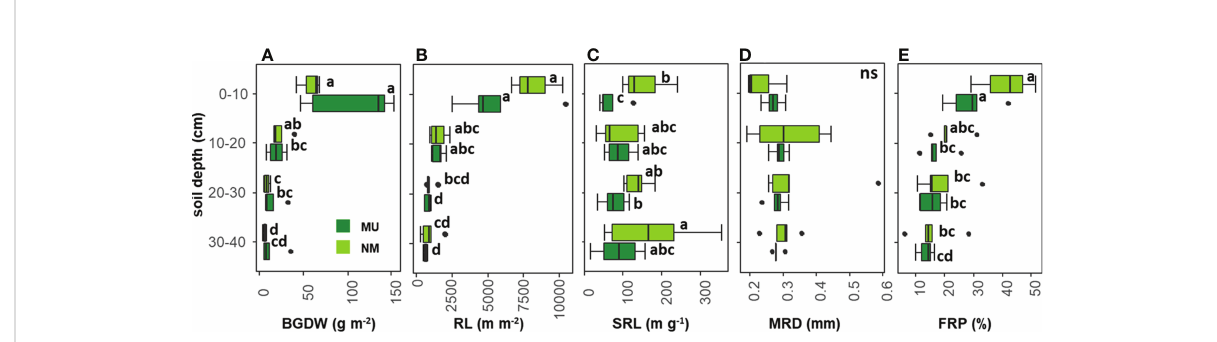
FIGURE 4 Comparison of community-level below-ground traits between control (NM; no mulching) and mulching-treated (MU) areas for each soil depth layer. The boxplot indicates the median (line in the middle of the boxes), the interquartile range (boxes), 1.5 times the interquartile range (whiskers) and outliers (circle). Small letters indicate the results of the Dunn test post-hoc comparisons; ns, not signi fi cant (p > 0.05). BGDW, below-ground dry weight (A) ; RL, root length (B) ; SRL, speci fi c root length (C) ; MRD, mean root diameter (D) ; FRP, fi ne-root percentage (E)